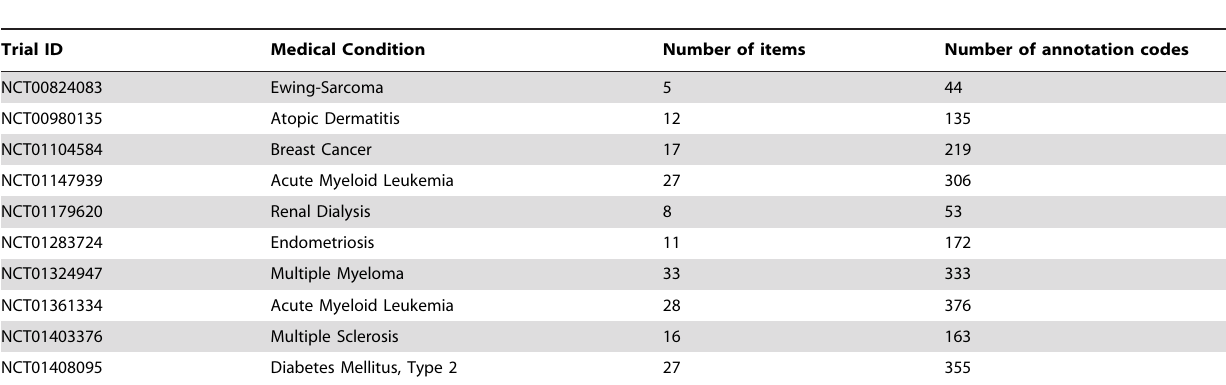
Trial ID Number of